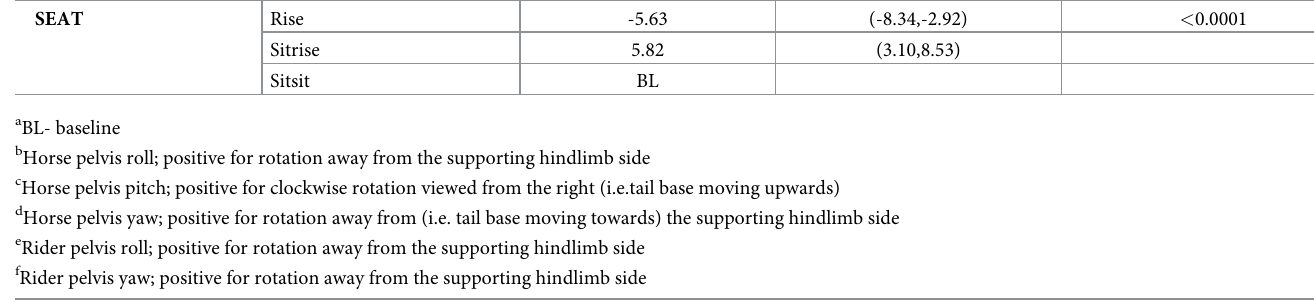
on subjective evaluation [1–3]. In this study we used objective measures of oscillations of the saddle with high temporal resolution and multivariable models to evaluate associations between horse and rider movements and the magnitude of lateral saddle movement during the stride cycle in well-ridden, non-lame horses without evidence of clinically relevant saddle slip. Saddle movement was assessed based on the position of the caudal part of the saddle, illus- trated by photos taken from behind [1]. In this study we used markers placed at the caudal part of the saddle and at L3 of the horse, and measured the distance between them in right angles to the horse’s dorsal midline. The maximum distance, representing maximum lateral movement of the saddle towards the weight-bearing hindlimb side during each diagonal step, was used as outcome variable in multivariable models. Considering the explanatory variables that remained in the final model, three of the four variables related to the rider’s movements were significant (SEAT and roll and yaw of the rider’s pelvis, but not maximum saddle force), whereas only one of the many variables related to the horse’s movements was retained. The Table 3. Multivariable mixed models. Model results for the outcome lateral movement of the saddle in relation to the horse spine in mm, for rising and sitting trot data (590 diagonals, 20 trials, 7 horses) and from sitting trot data (208 diagonals, 7 trials, 7 horses). Estimates and their 95% confidence intervals (95% CIs) are provided. Rising and sitting trot (n = 590)